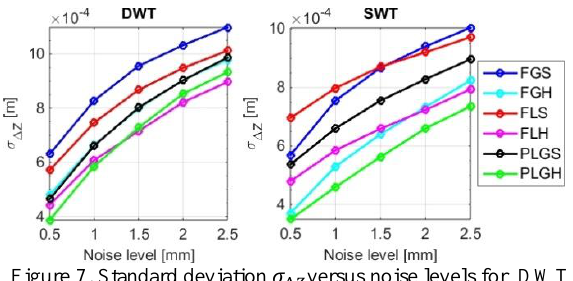
Figure 7. Standard deviation 𝜎 Δ𝑍 versus noise levels for DWT (left) and SWT (right) denoised surfaces applying six thresholds.